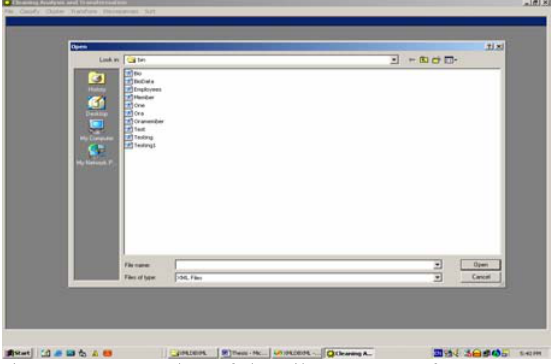
Figure 3: A Snapshot of the File Open Interface, to open XML data sources for transformations.